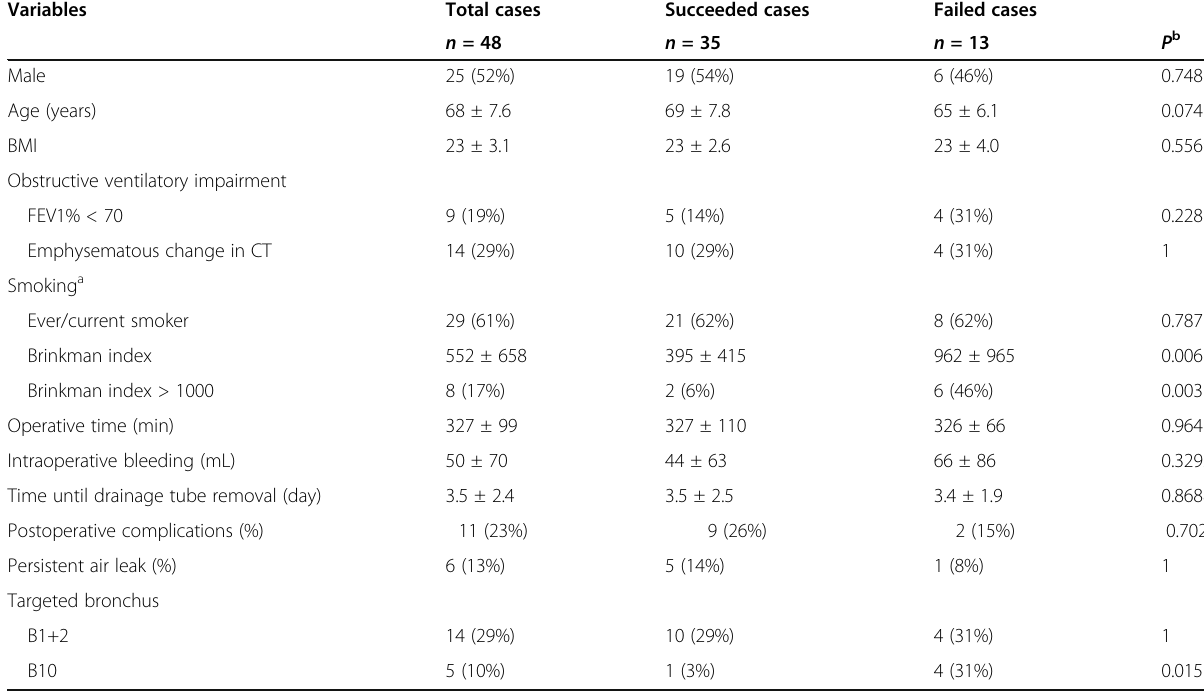
Table 1 Patient characteristics Variables